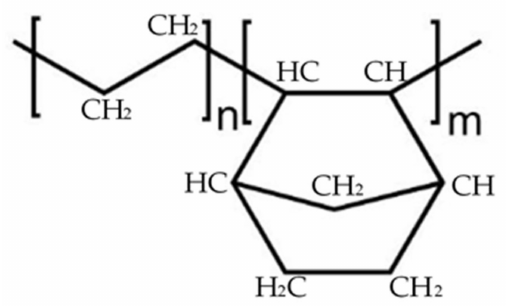
Figure 1. Structure of the two cycloolefin